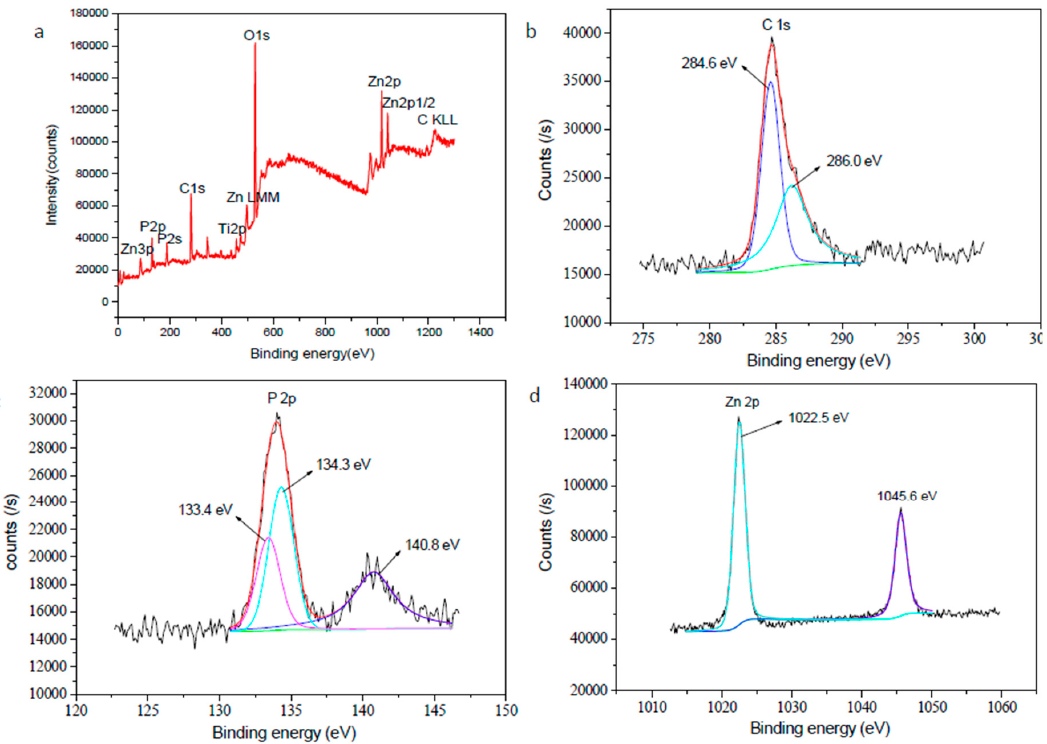
Figure 6. X-ray photoelectron spectroscopy (XPS) spectra of MAO coatings obtained under current density 50 mA/cm 2 , duty cycle 35%, pulse frequency 2000 Hz and treating time 3.0 min in the solution containing 10 g/L EDTA-ZnNa 2 , 2 g/L KOH and 8 g/L phytic acid: ( a ) survey; ( b ) C1s, ( c ) P 2p, ( d ) Zn 2p.